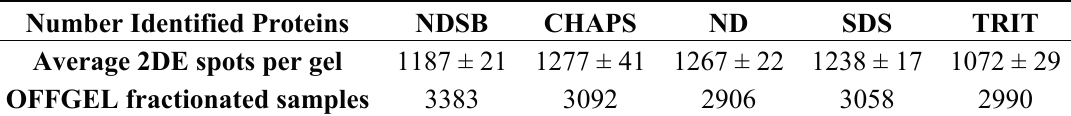
Table 1. Number of proteins identified from the different solubilization buffers for two-dimensional gel electrophoresis (2DE) and OFFGEL fractionation methods. Standard errors from three biological replicates are shown for 2DE analysis